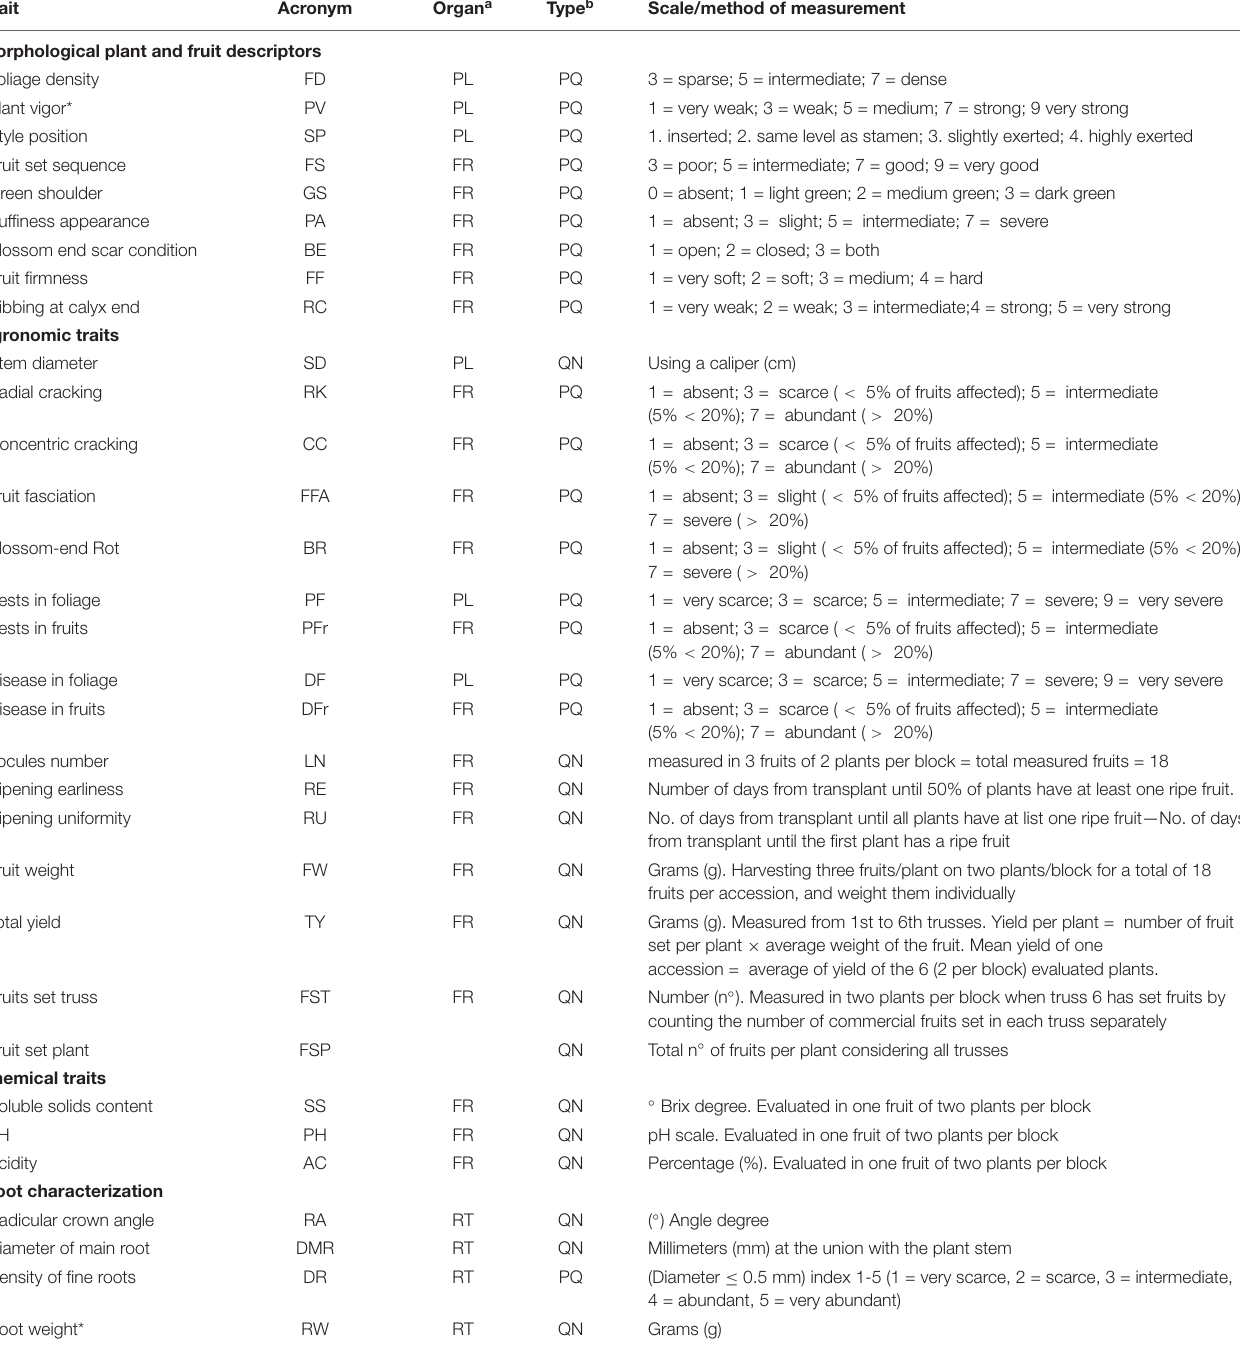
TABLE 2 | List of traits analyzed and method of measurement for the 42 cultivated tomato accessions analyzed in control, water deficit, and nitrogen stress conditions in Italy and Spain.